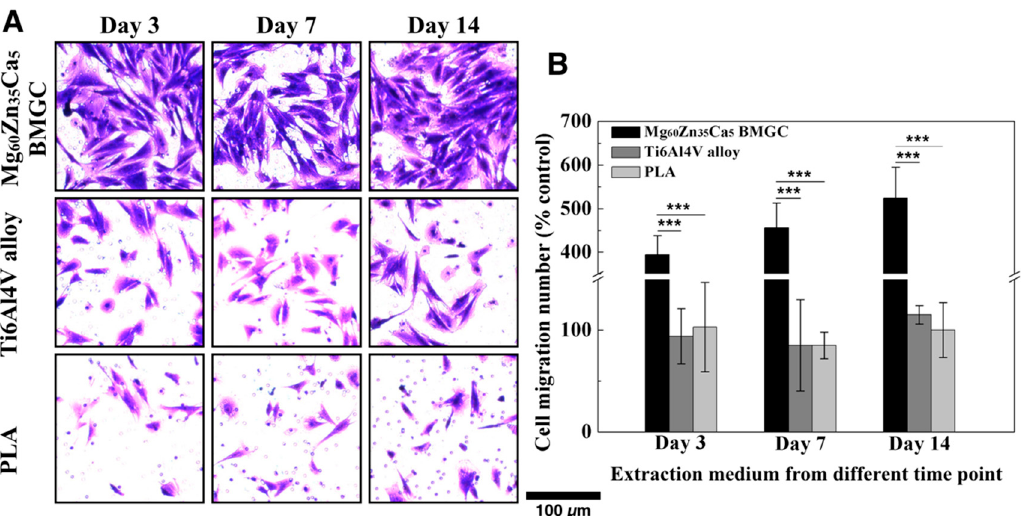
Figure 4. Migration capacity of primary rabbit osteoblasts under treatment with different extraction medium. ( A ) Image of migrated cells stained with crystal violet. ( B ) Quantitation of migrated cell number of primary rabbit osteoblasts cultured in different extraction medium for different time periods. (Data normalized with control group: without extraction medium; *** p < 0.001.)